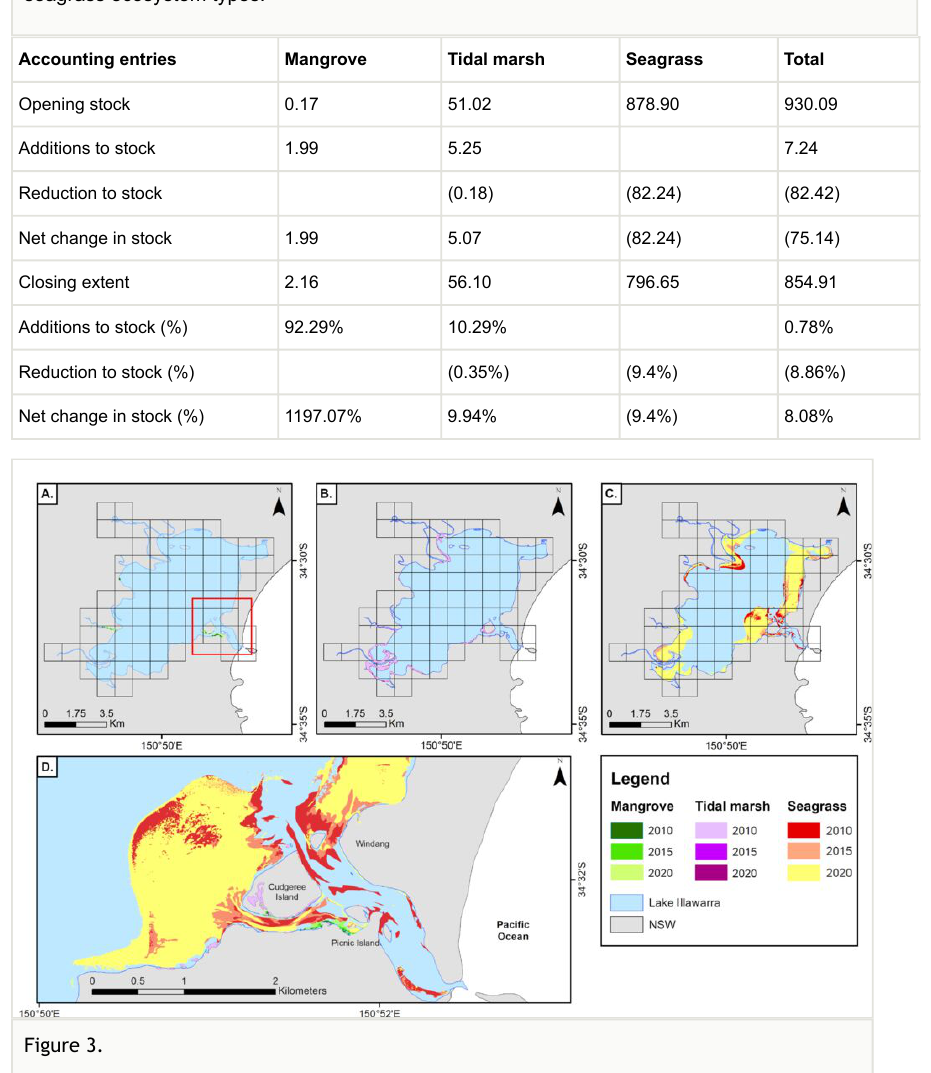
Ecosystem extent for the (A) mangrove, (B) tidal marsh and (C) seagrass coastal ecosystems for the 2010, 2015 and 2020 accounting periods. Basic spatial units used in ecosystem accounting overlayed. The (D) change at the Lake entrance and flood-tide delta is shown for all three ecosystems, with the location indicated in the red within